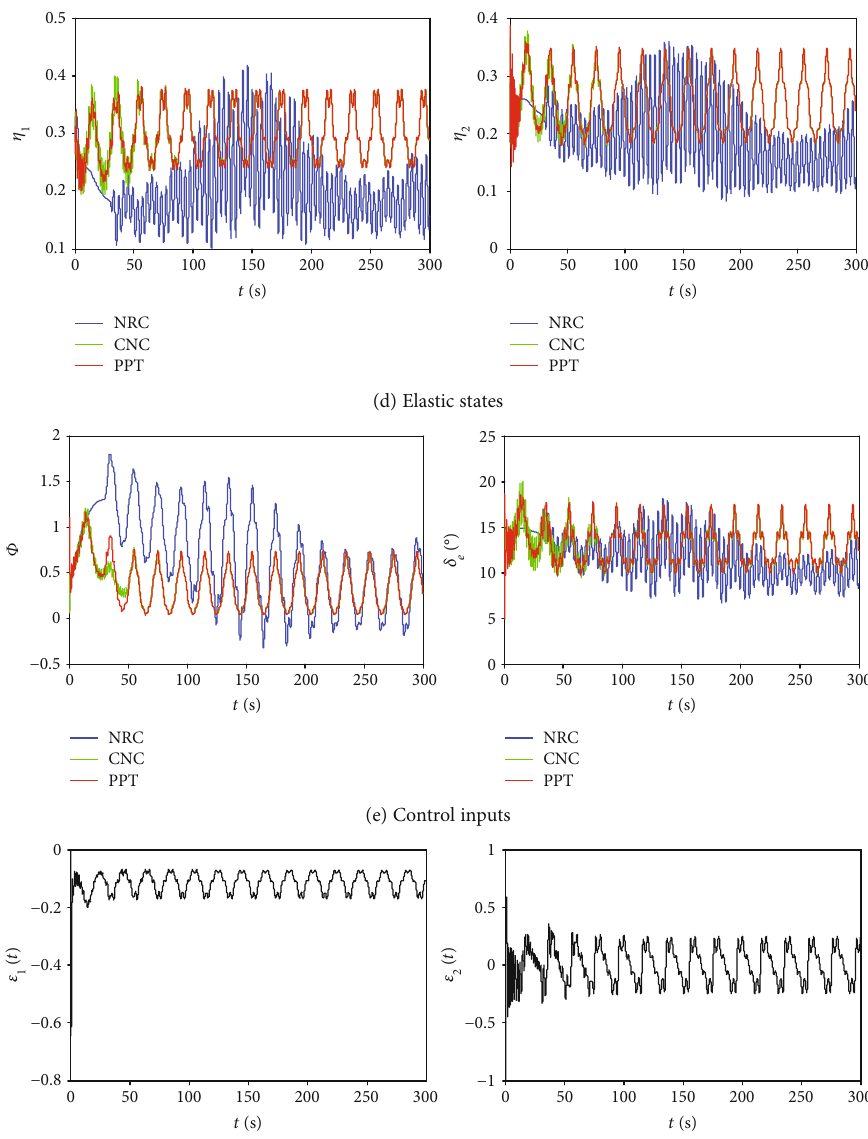
Figure 2: Case 1 simulation